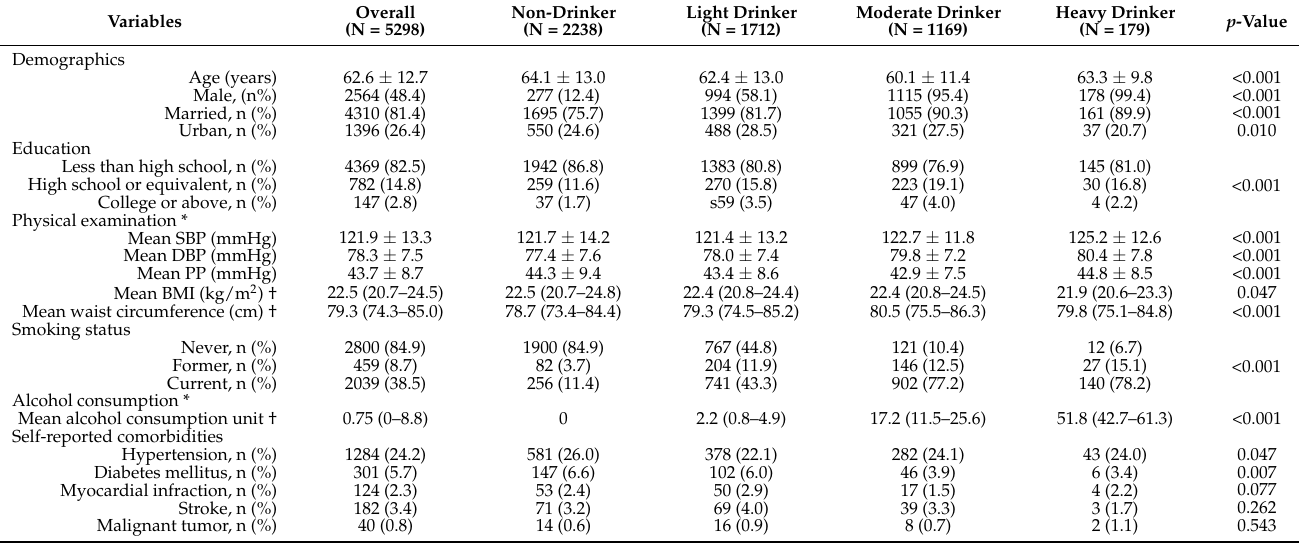
Table 1. Baseline characteristics according to different alcohol-consumption trajectory classes.